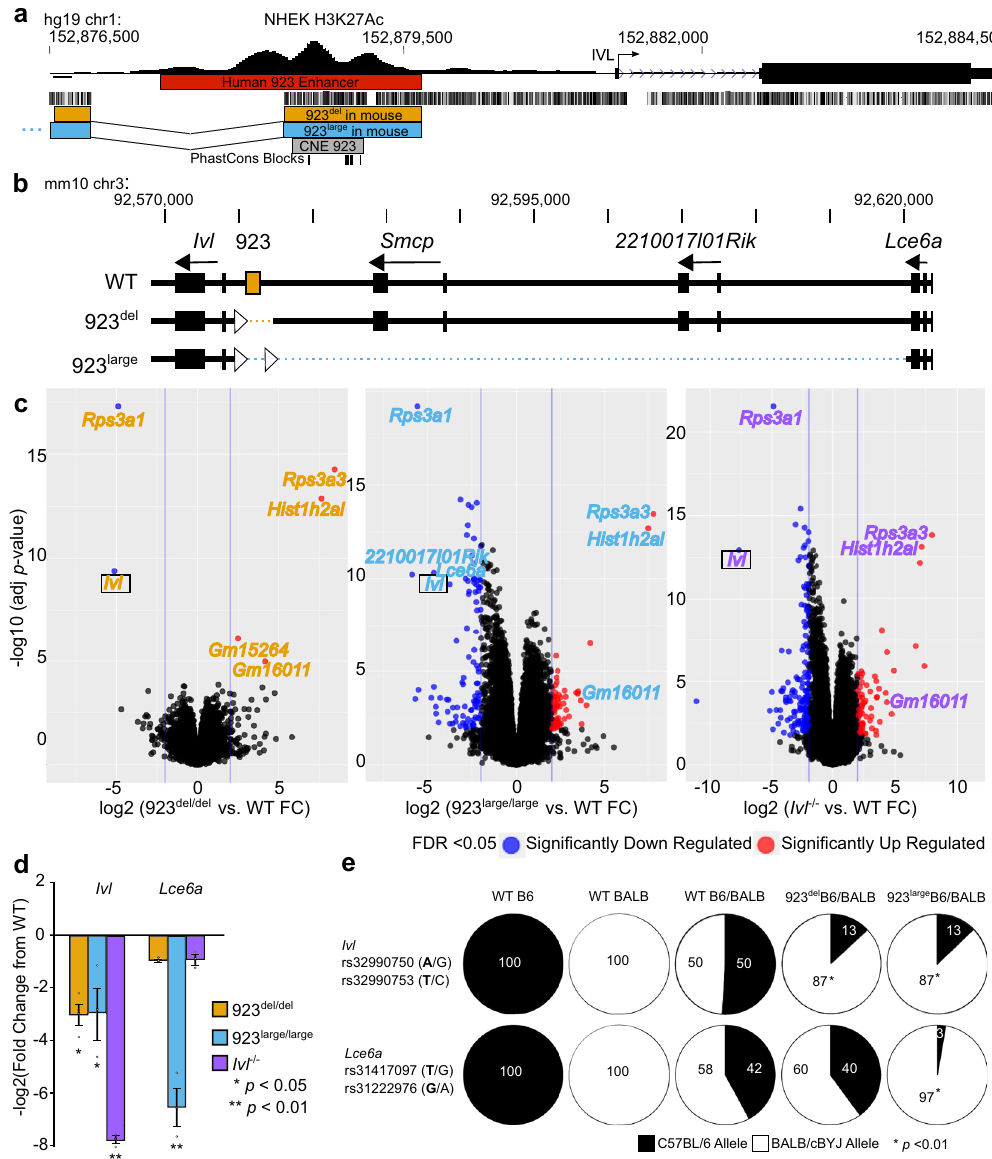
Fig. 3 Deletion of the 923 enhancer in vivo identi fi es involucrin as a target gene via cis regulation. a Schematic of the human 923 enhancer (red) as de fi ned by H3K27Ac marks in NHEK (Normal Human Epidermal Keratinocytes); hg19; chr1:152,877,349-152,879,610, the conserved noncoding element (CNE) 923 with PhastCons blocks (gray); hg19; chr1:152,878,419-152,879,075 and the orthologous deleted enhancer sequence (923 del ; orange) and larger deletion (923 large ; blue) in the mouse with alignments to human as shown. b Generation of two 923 enhancer deletion alleles by CRISPR/Cas9 genome editing in mice shown as dotted lines, 923 del (mm10 [ Mus musculus ]; chr3: 92,575,843 – 92,577,094): Deletion of mouse orthologous 923 enhancer; 923 large : ~40 kb deletion (mm10; chr3: 90,575,863 – 92,577,075) that includes 923 enhancer, Smcp , and 2210017I01Rik annotations. Intact fl anking loxP sites (triangles) were also successfully introduced via homologous recombination. c Volcano plots of ribosomal-zero RNA-seq differential gene expression analyses of 923 del/del (orange text), 923 large/large (light blue text), and Ivl − / − (purple text) newborn mouse skins each compared to wild-type (WT) reveal signi fi cant decreased expressions for Ivl . n = 3/genotype. FC, fold change. Statistical analysis using Limma ’ s generalized linear model moderated two-sided t -tests with 22 degrees of freedom and Benjamini-Hochberg false discovery rate (FDR) corrections. Signi fi cant data points with FDR ≤ 0.05 in blue are log2 fold down-regulated ≤ − 2 and red are up-regulated ≥ 2. d Con fi rmatory qPCR validation for decreased Ivl expression for 923 del/del ( p = 0.030), 923 large/ large ( p = 0.034), and Ivl − / − ( p = 0.001), and additional decreased Lce6a expression speci fi c to 923 large/large newborn mouse skins ( p = 0.001) all compared to WT mice; n = 3/genotype; Error bars ±SEM. One-way ANOVA followed by Tukey ’ s HSD displayed. e Proportions of allele-speci fi c (SNP) Ivl and Lce6a expression shown in pie charts for each mouse strain. Two SNPs per allele were measured and showed identical allele frequencies. B6 SNP bolded, * p < 0.01, one-way ANOVA compared to WT B6/BALB